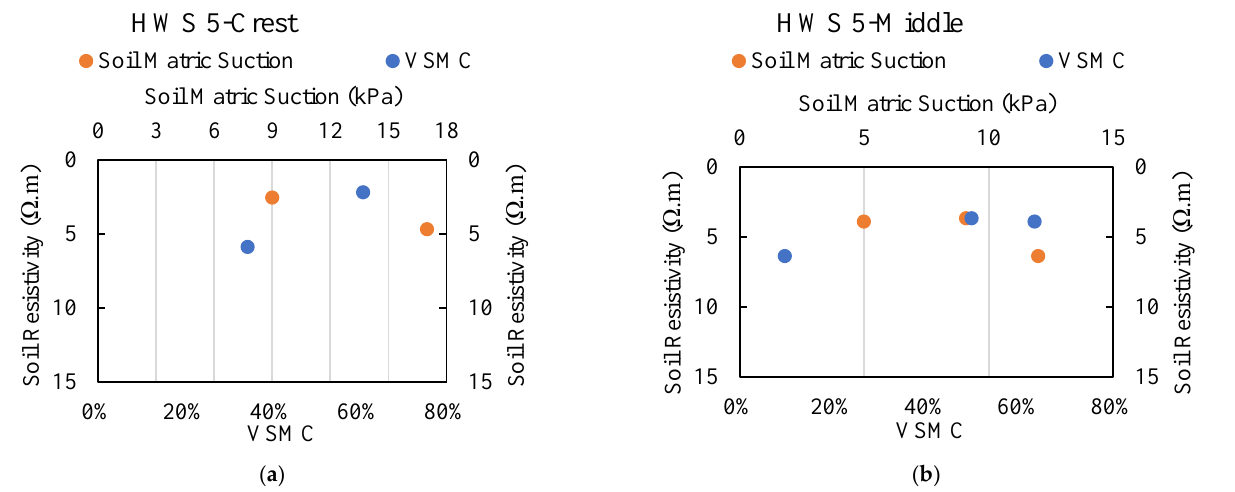
HWS 6 is located along I20 E near McRaven road. The HWS6 descriptive illustrations are presented in Figure 28. The HWS has shown signs of movement. Three 15 ft (5 m) boreholes were drilled and then instrumented at the crest, middle and toe of the slope. In Figure 28, the three instrumentation locations are designated as Instrumentation I, Instru- Figure 27. HWS 5 comparison of 2D ERI test profile with field instrumentation ( a ) At crest of the slope ( b ) At middle of the slope (1 m = 3.28 ft; 1 mm = 0.039 in; 1 kPa = 20.89 psf). mentation II and Instrumentation III.